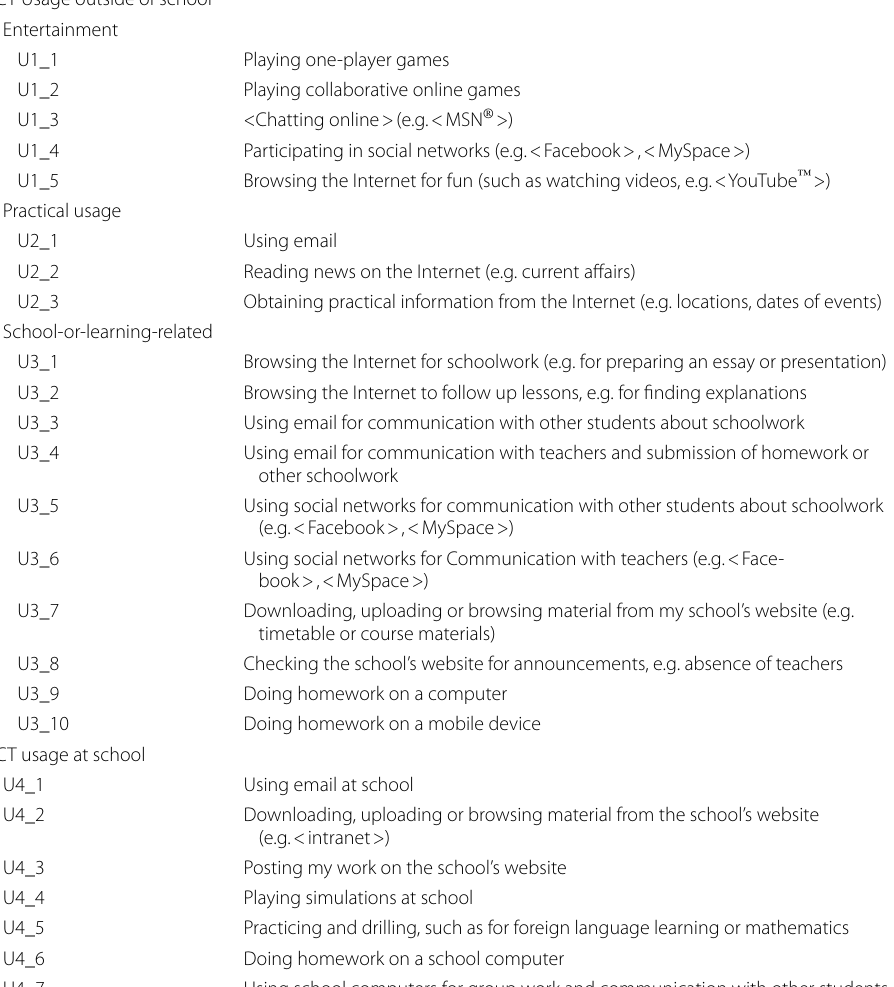
Table 2 Items for the assessment of ICT Usage outside of school and at